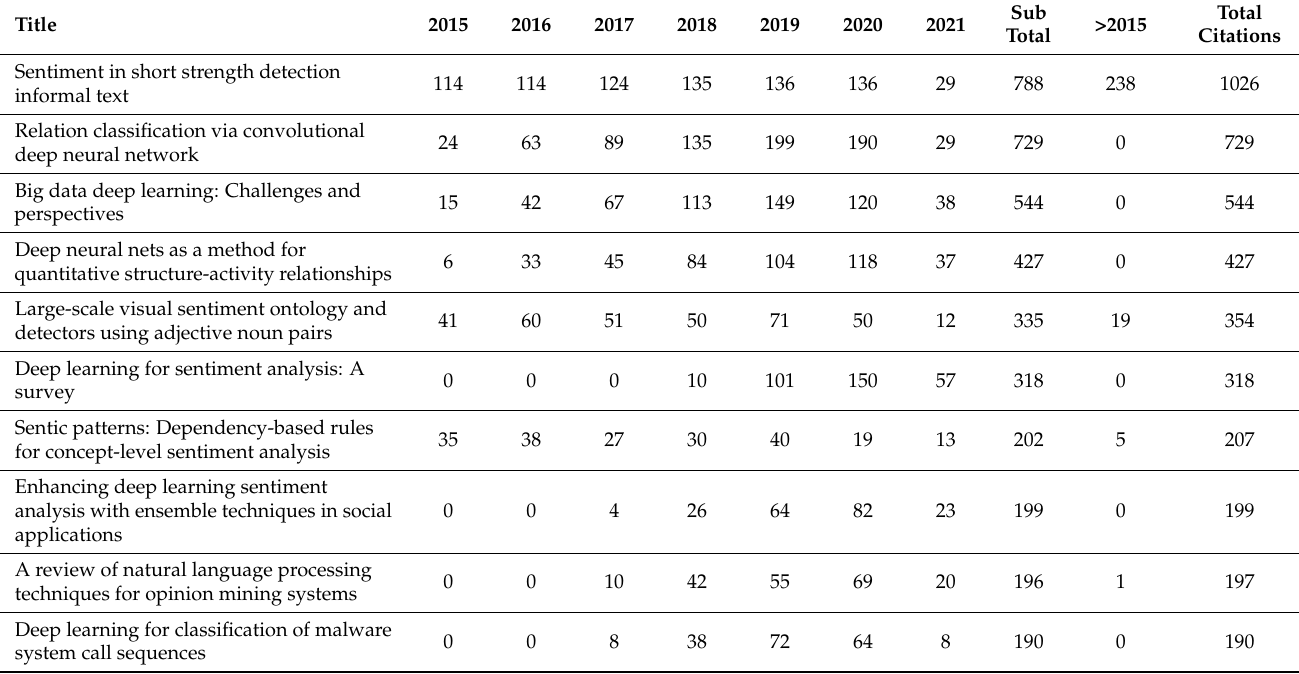
Table 18. A citation analysis of the top ten publications on